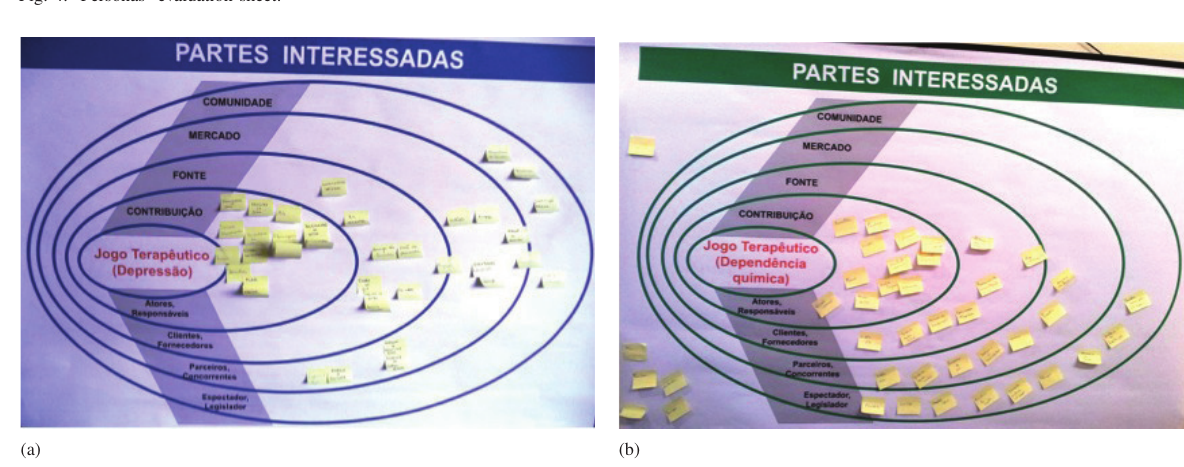
Fig. 4. Personas’ evaluation sheet.